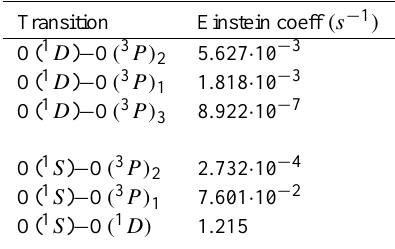
Table 2. Transition probabilities from O( 1 S) and O( 1 D) . Einstein coefficients recommended by Itikawa and Ichimura (1990).